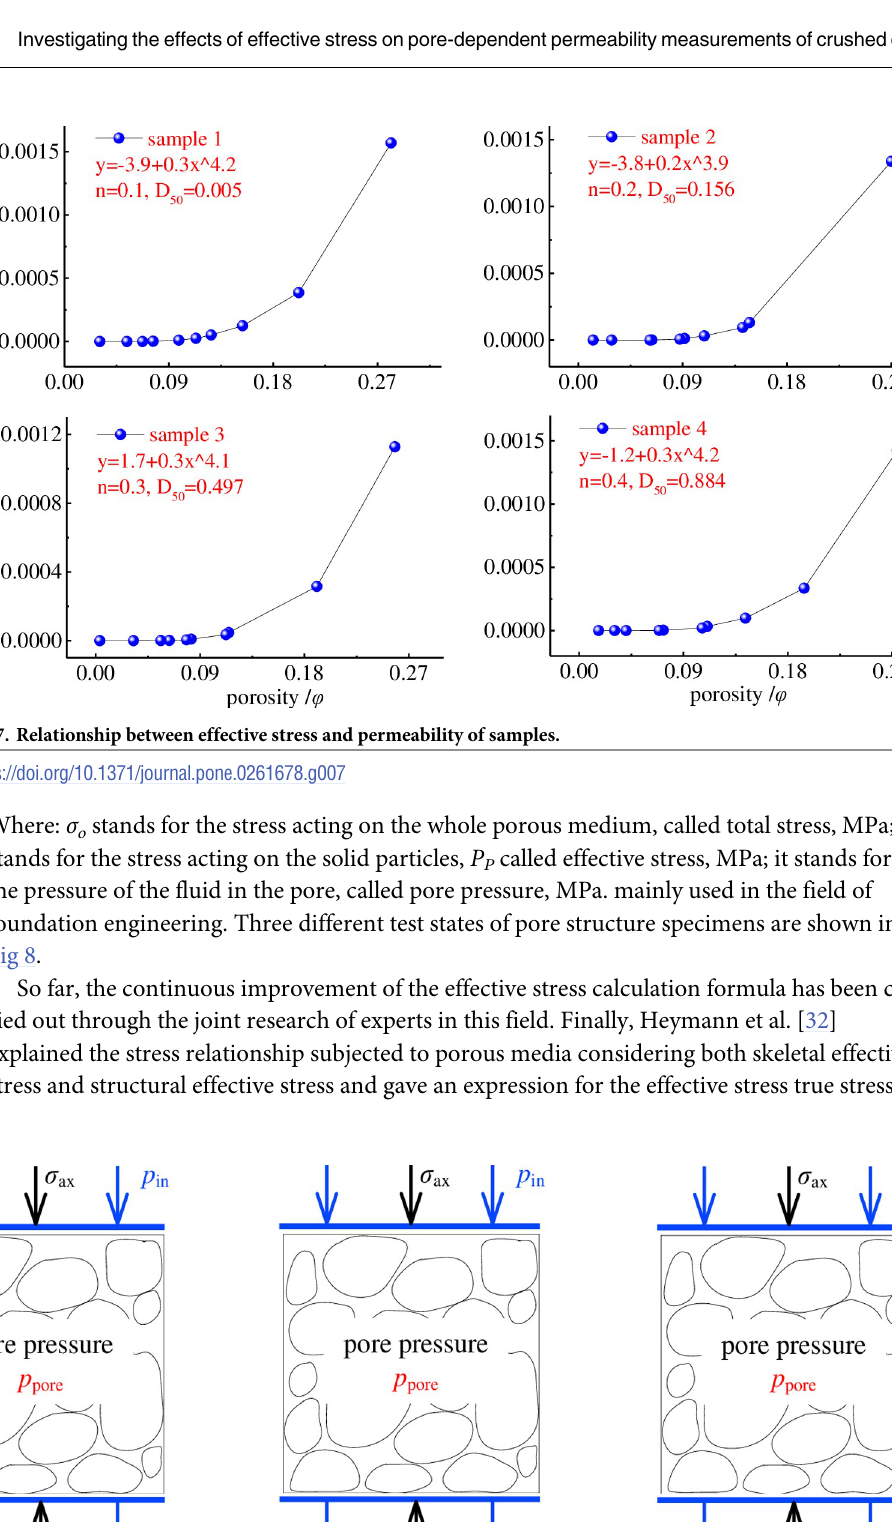
Fig 8. Three different test states of pore structure